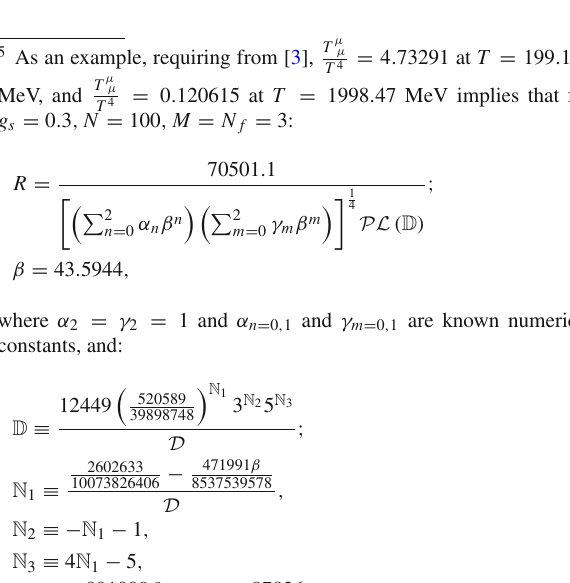
where the uncertainties are obtained from the diagonal ele- ments of the covariance matrix.